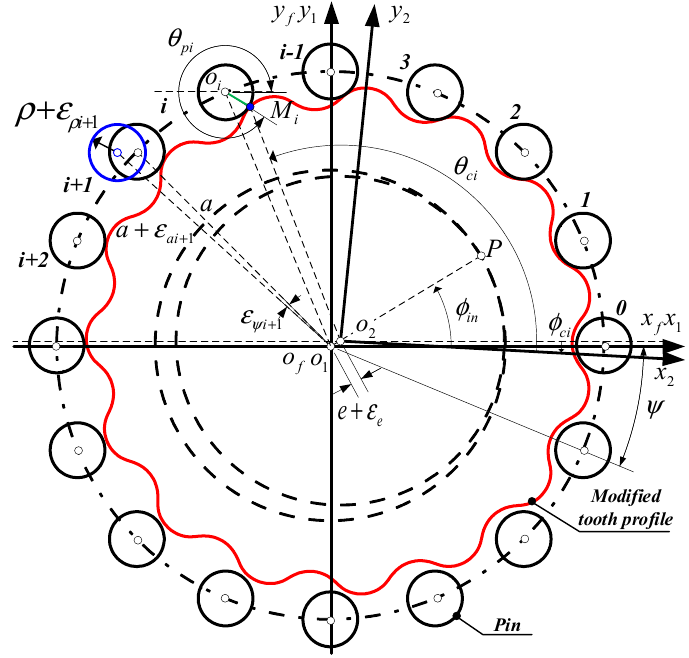
Figure 4. Flowchart of the load distribution analysis for the cycloid-pin gear pair.